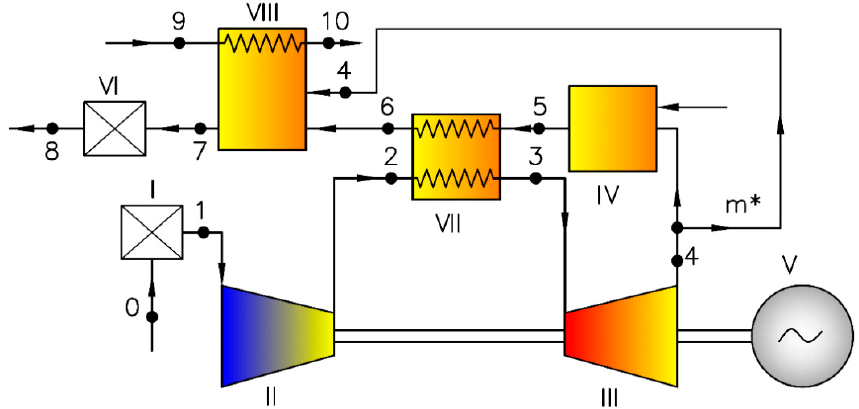
Figure 14. Circulation diagram with air turbine, external combustion chamber and bypass and cogeneration (Variant 4-V4). I–filter; II–compressor; III–turbine; IV–external combustion chamber; V–electric generator; VI–silencer; VII–regenerator; VIII- heat exchanger (for cogeneration heat).